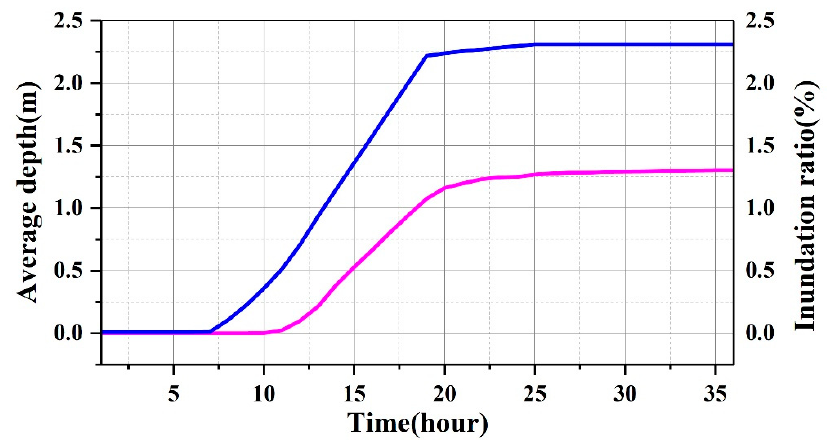
Figure 9. The changes in average water depth and inundation ratio.